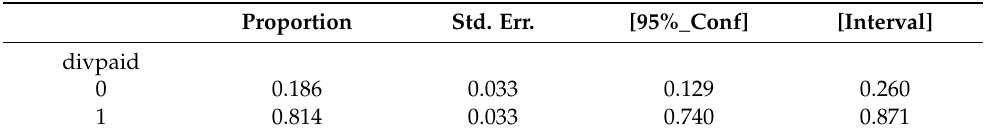
Table 4. Descriptive statistics for the dummy variable.